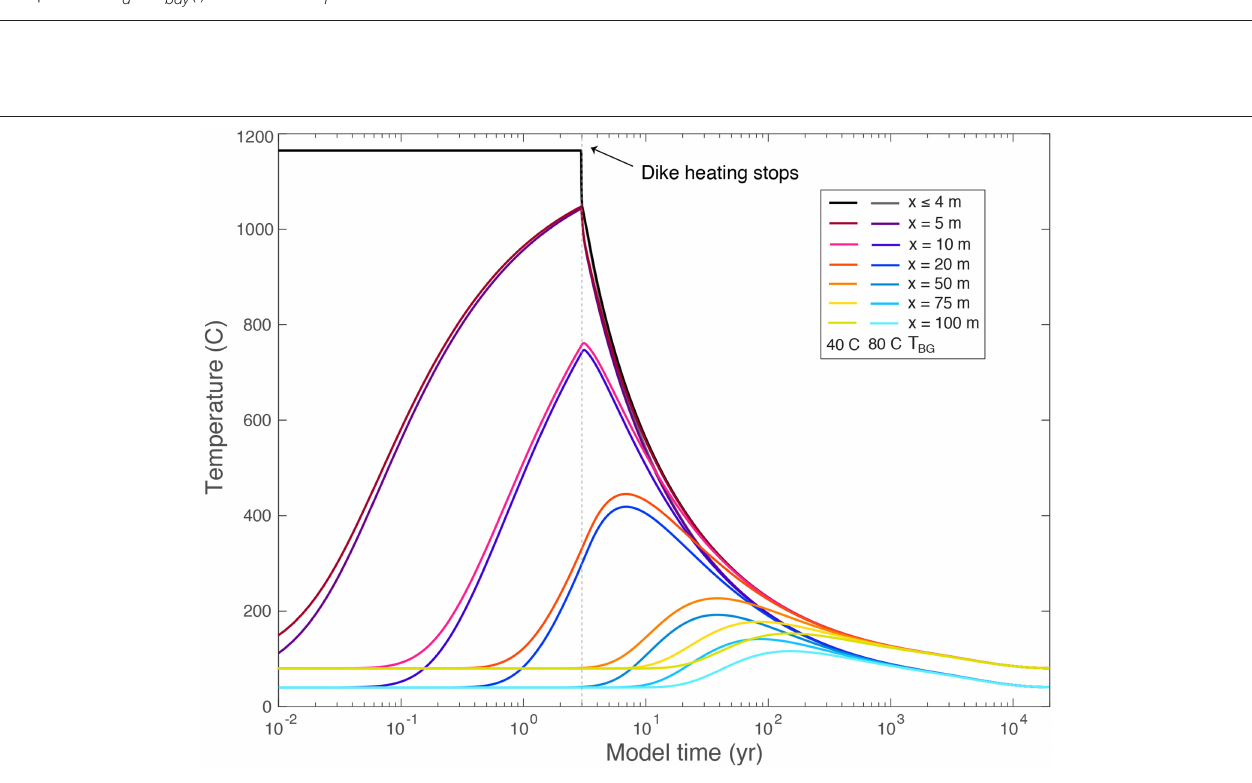
FIGURE 6 | Temperature as a function of distance from dike center x and time for an example H / 2 = 4 m thick dike emplacement scenario and two background temperatures T BG (red and blue colors). Dike interior temperature evolution is given by the black curve. Forced heating by magma flow is close to a step function in time ( τ c = 3 yr, τ w = 0.1 yr, giving τ f = 3.04 yr, k = 3 W/mC ), and stops at the time indicated by vertical dashed line.